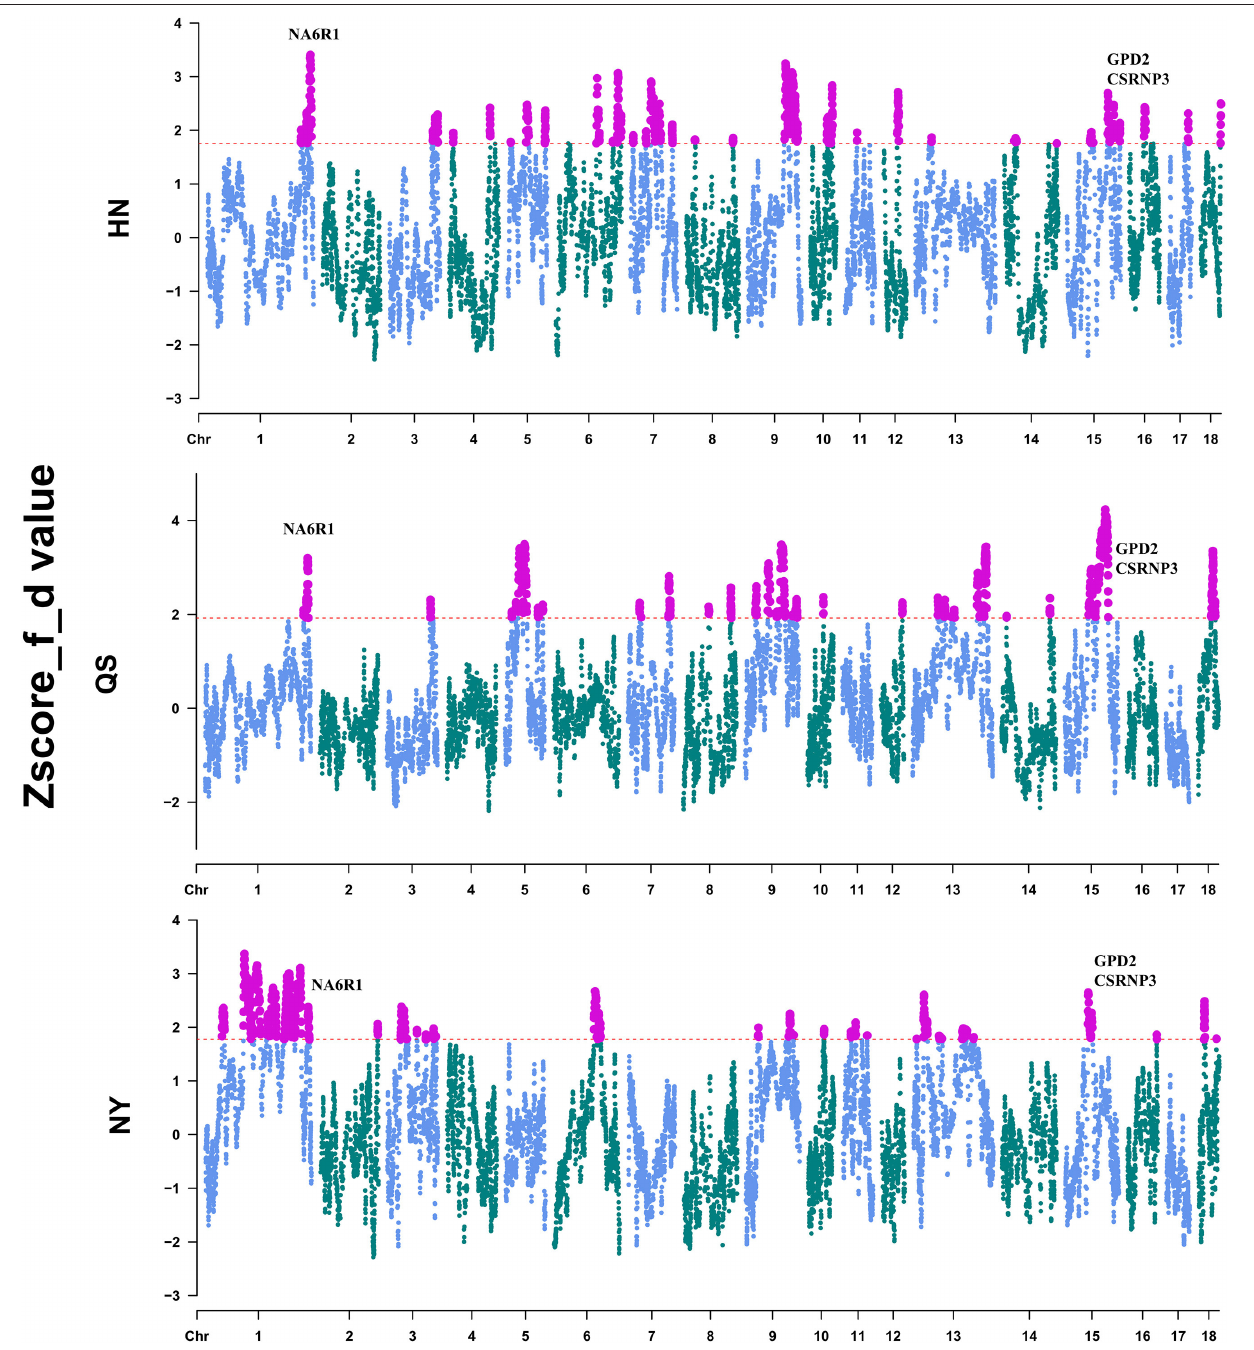
FIGURE 3 | Identification of the introgression region of Duroc pigs to Henan indigenous pigs. The red dashed line shows the 5% cutoff used to define the introgression region.